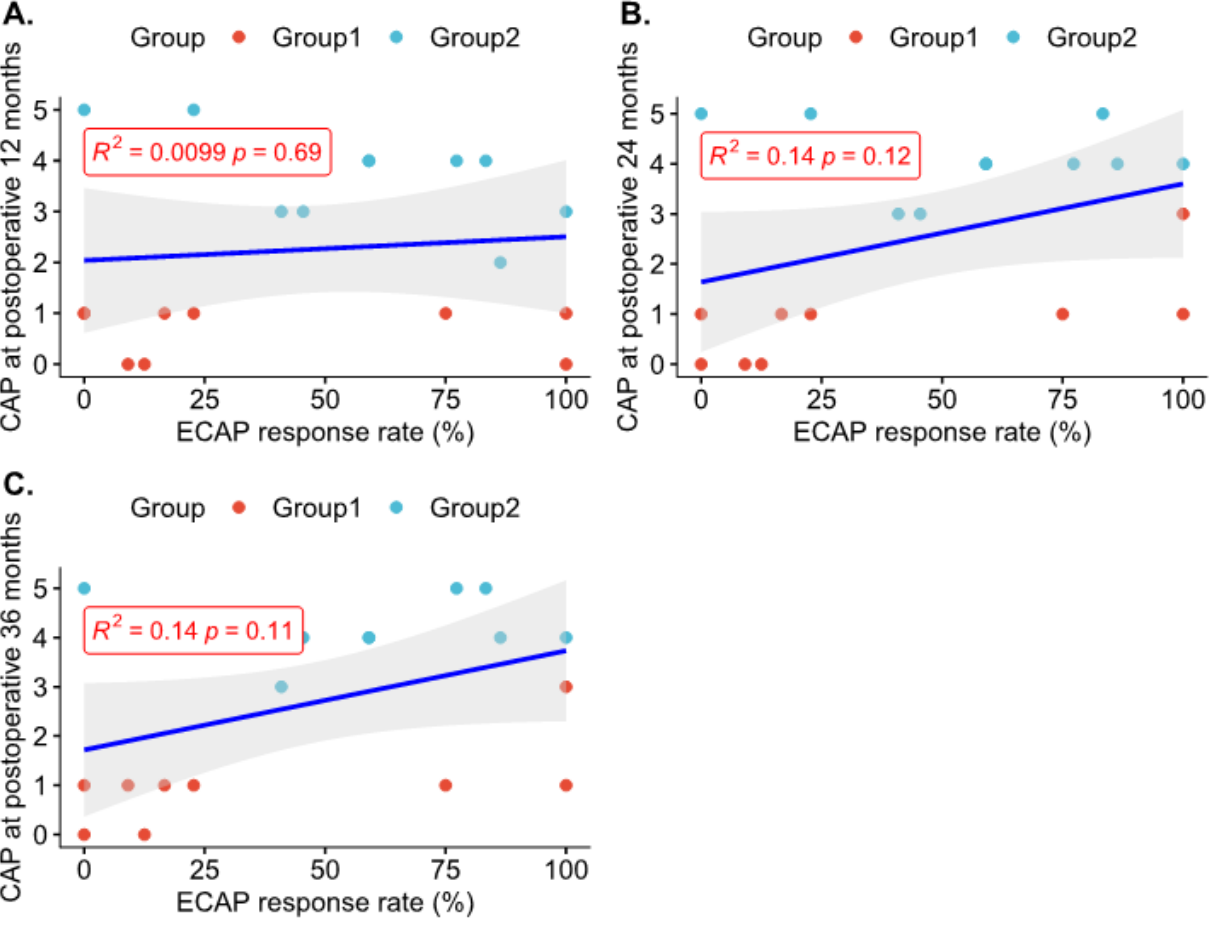
Figure 4. Correlation analyses between the intraoperative positive ECAP ratio and CAP scores at postoperative stages. No statistically significant correlations between intraoperative ECAP response rate and CAP scores at 1 ( A ), 2 ( B ) and 3 years ( C ) after surgery were illustrated (using Spearman’s correlation analysis). Group 1 consisted of participants with CAP scores of 0-1 at 1 year postoperation, and Group 2 consisted of participants with CAP scores ≥ 2 at 1 year postoperation. CAP, Category of Auditory Performance; ECAP, electrically evoked compound action potential.